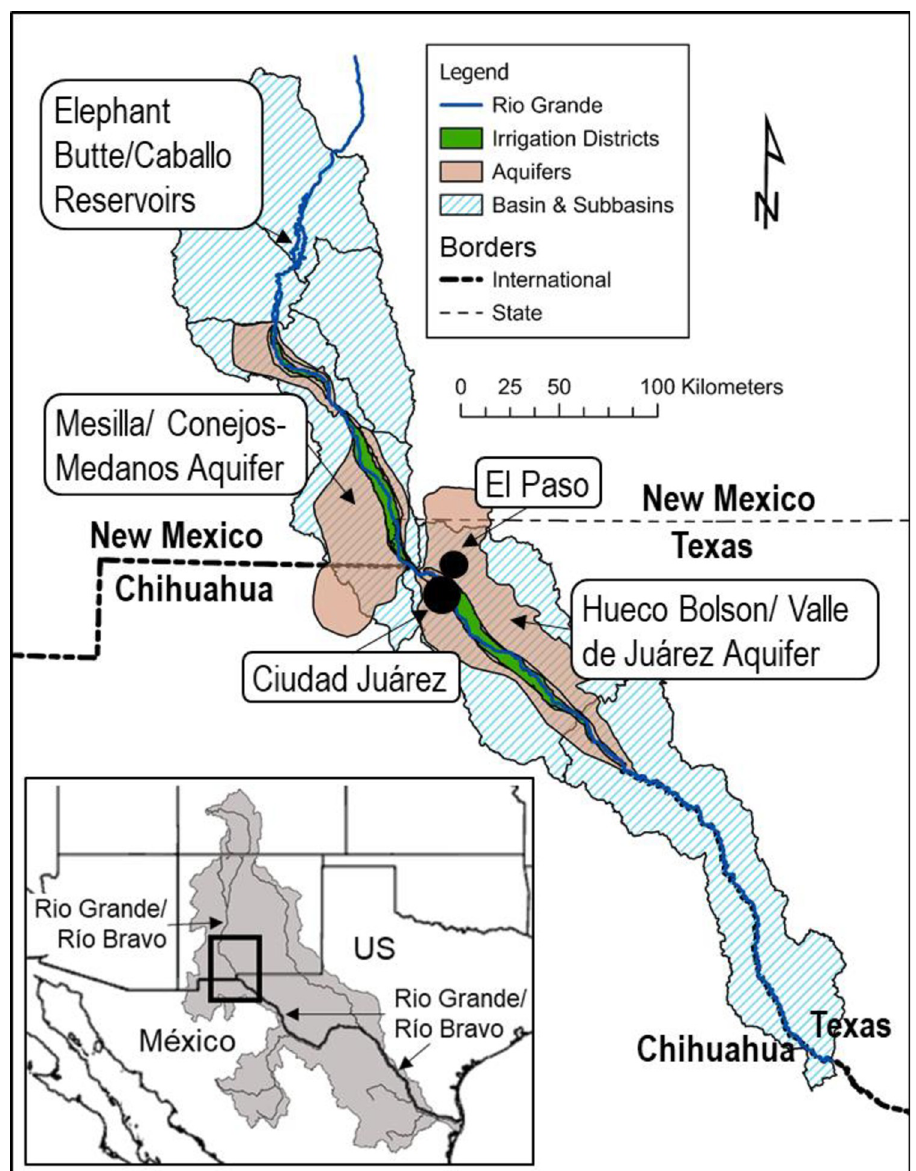
Fig 1. Study area map indicating major sources of water supply for El Paso Water and other users. Source: Hydrological features, work of the authors; basemaps, US Census.